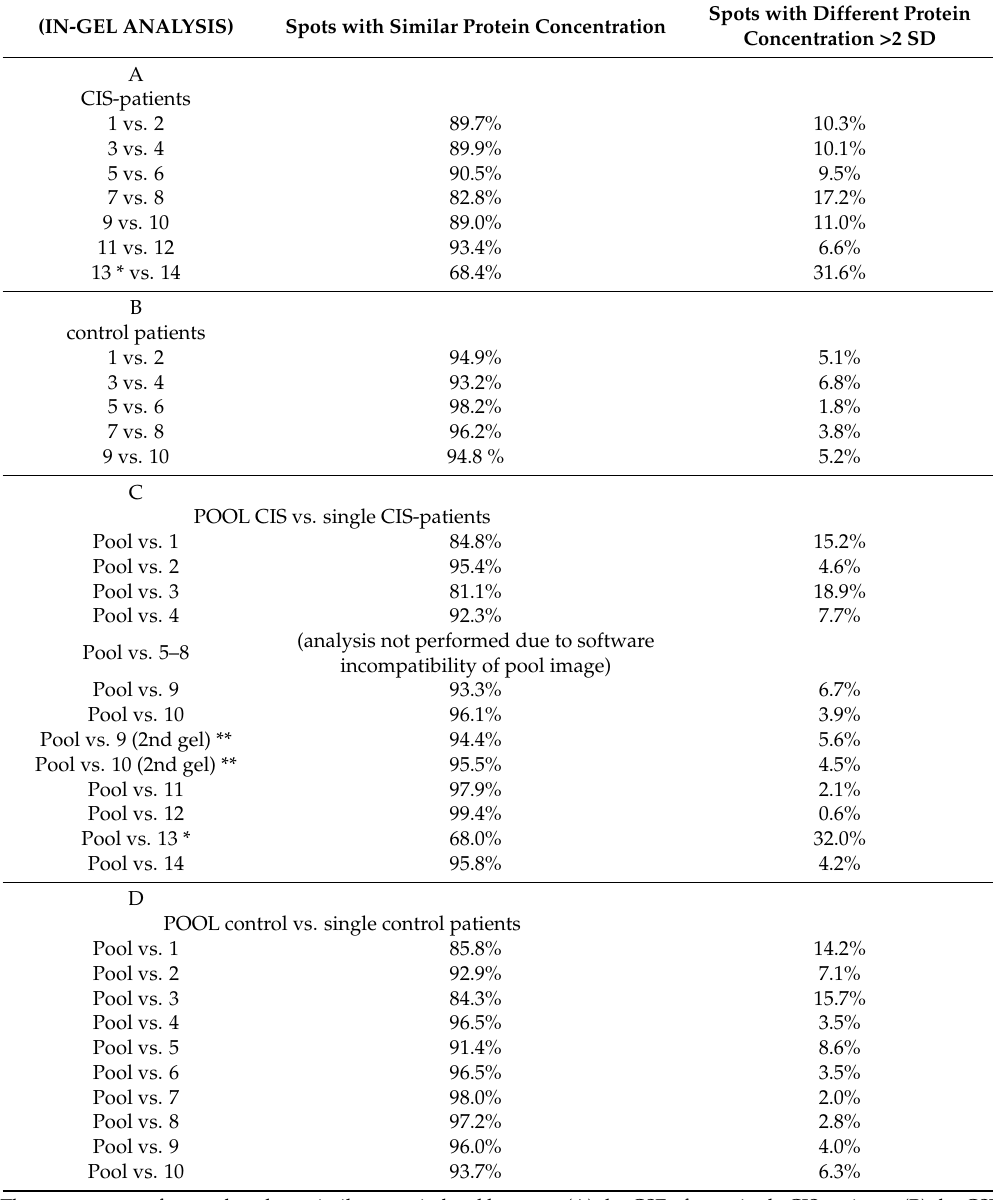
Table 2. Percentage of spots with similar protein level in samples within single